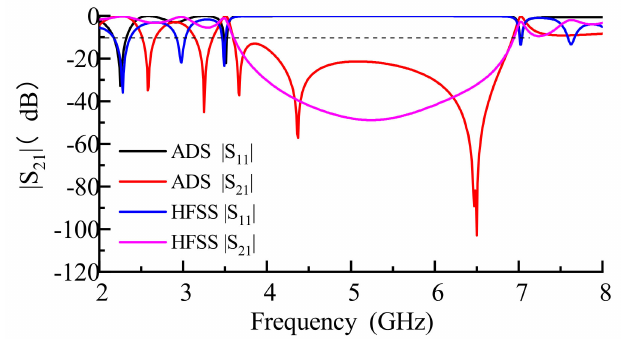
Figure 12. Simulation results of the comparison of the microstrip band stop filter etched with periodic hexagon rings.